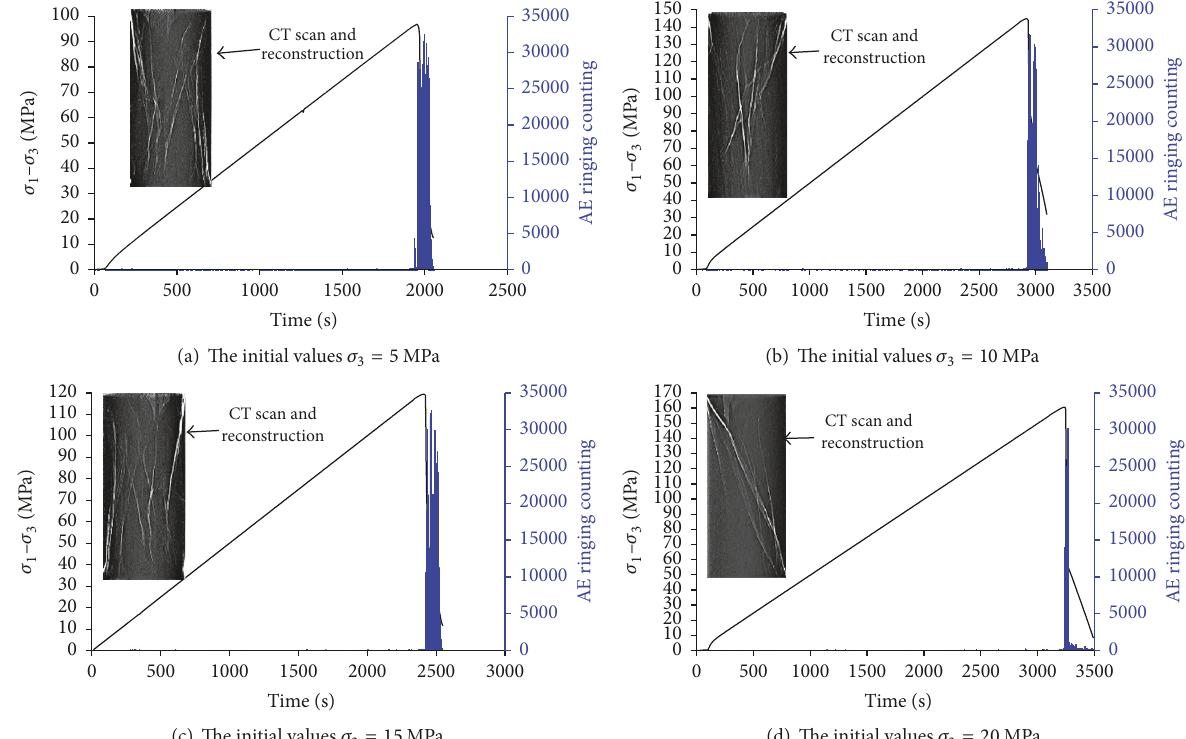
Figure 8: Test results of AE ringing counts of rock specimens under the unloading confining